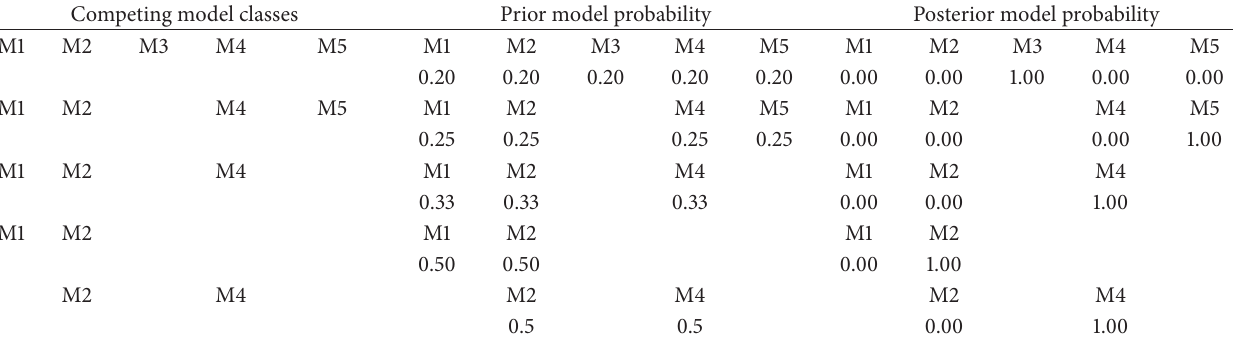
Table 6: Competing model classes and their prior and posterior